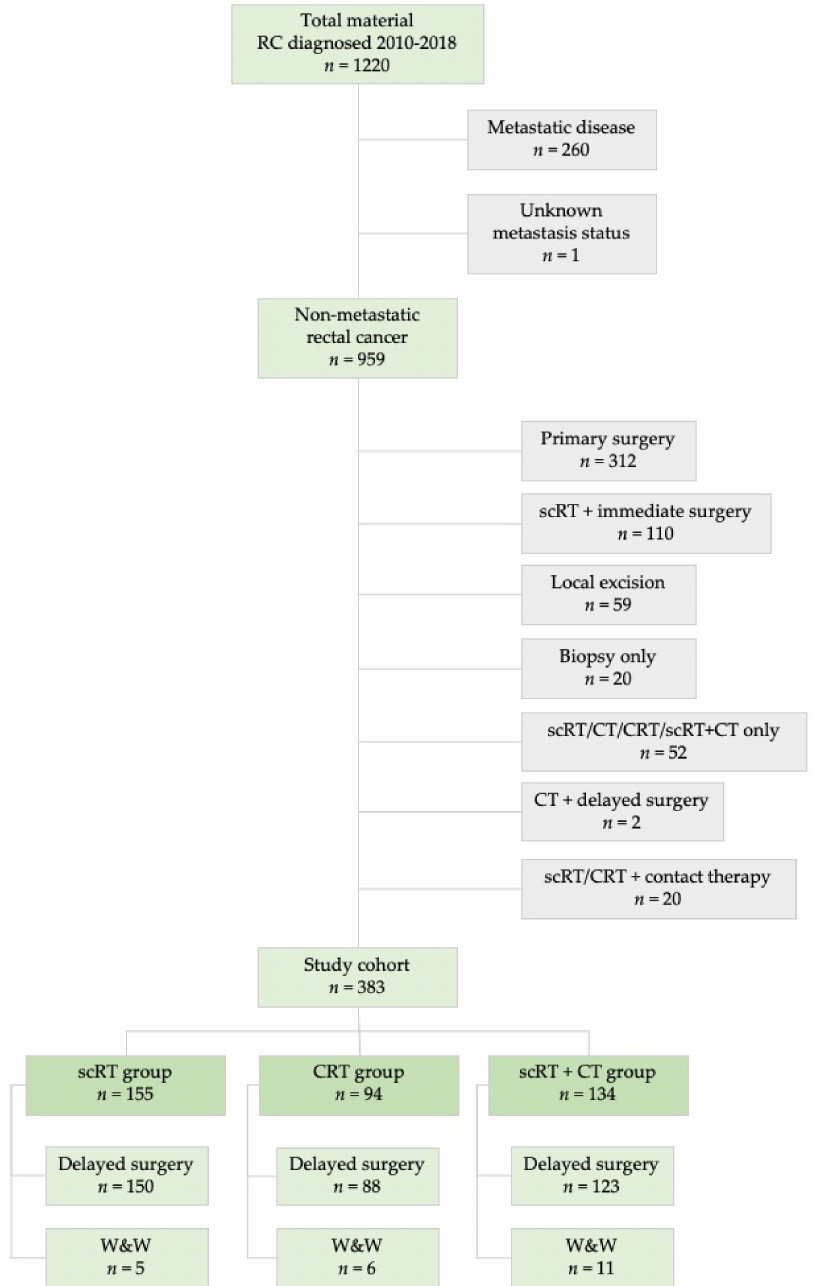
Figure 1. Flow chart of study cohort selection from the total cohort of 1220 rectal cancer patients diagnosed between 2010 and 2018 in two Swedish counties. Abbreviations: scRT = short-course radiotherapy; CRT = chemoradiotherapy; CT = chemotherapy; W&W = watch-and-wait. The durations of the delay after the last radiation fraction are shown in Table 1.